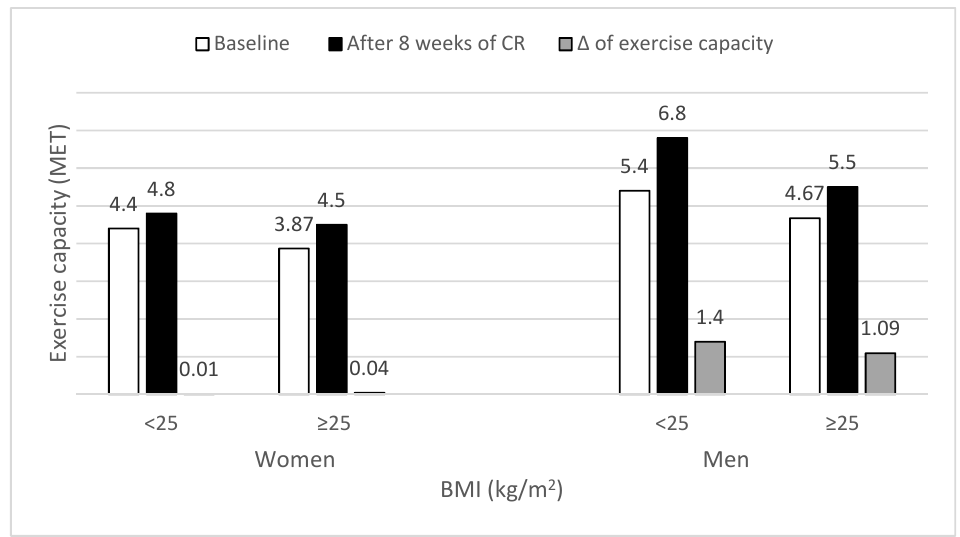
Figure 2. The exercise capacity of examined women and men with CAD at baseline and after 8 weeks of CR program in created BMI subgroups.